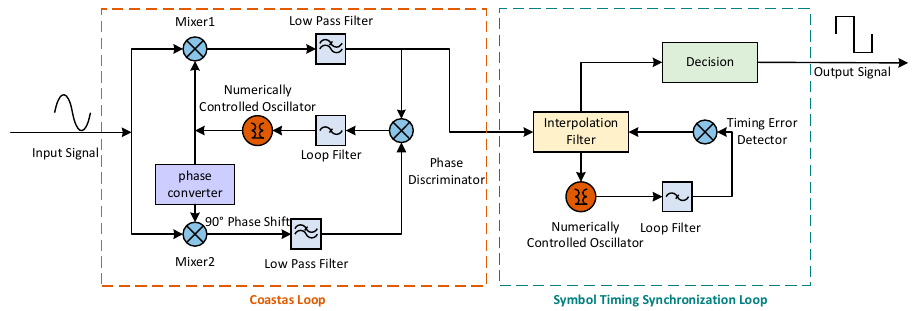
Figure 5. Principle of joint Costas loop and Gardner loop.